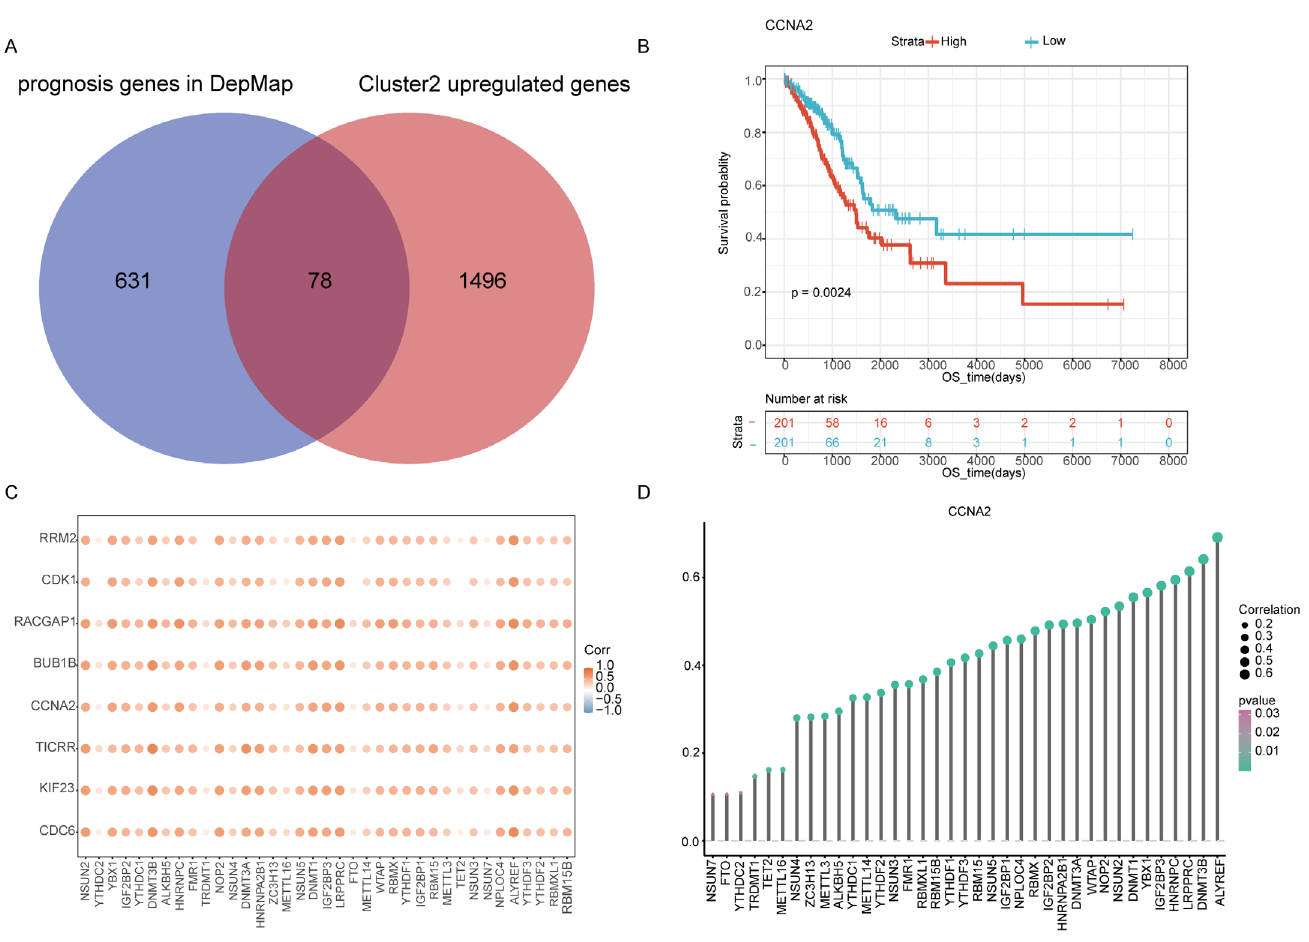
Figure 5. Screening of prognostic markers for early LUAD. ( A ) Venn diagram showing the intersection of cluster2 upregulated genes and the genes which are essential to LUAD human cell line growth using the DepMap database. ( B ) Kaplan–Meier analysis showing the association between the expression of CCNA2 and early-stage LUAD patient overall survival (OS) for the TCGA cohort. ( C ) Correlation between nine survival-related genes and m6A/m5C regulatory genes. ( D ) Correlation between CCNA2 and m6A/m5C regulatory genes.